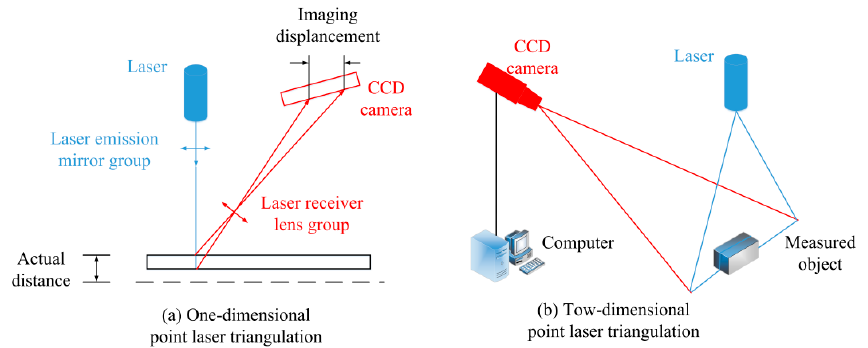
Figure 4. Basic principle of laser triangulation.